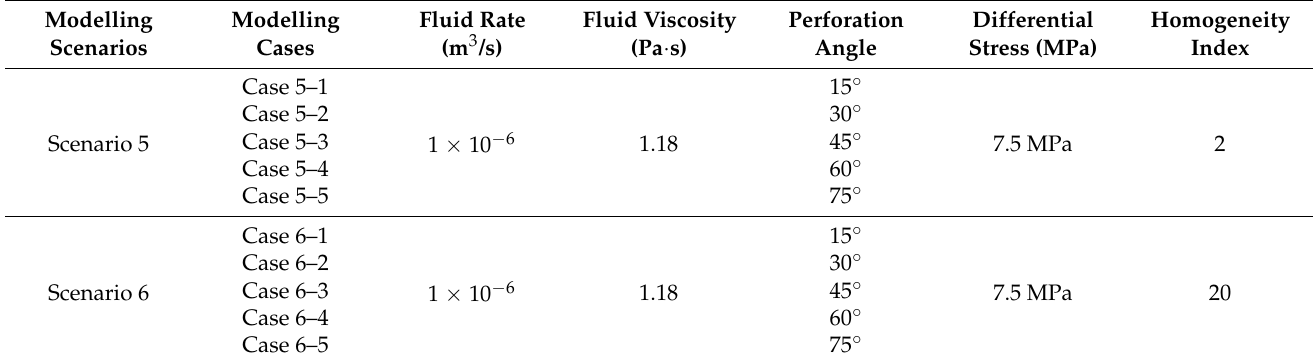
Table 8. Modelling scenarios to study the effect of perforation angle on HF re-orientation in heteroge- neous